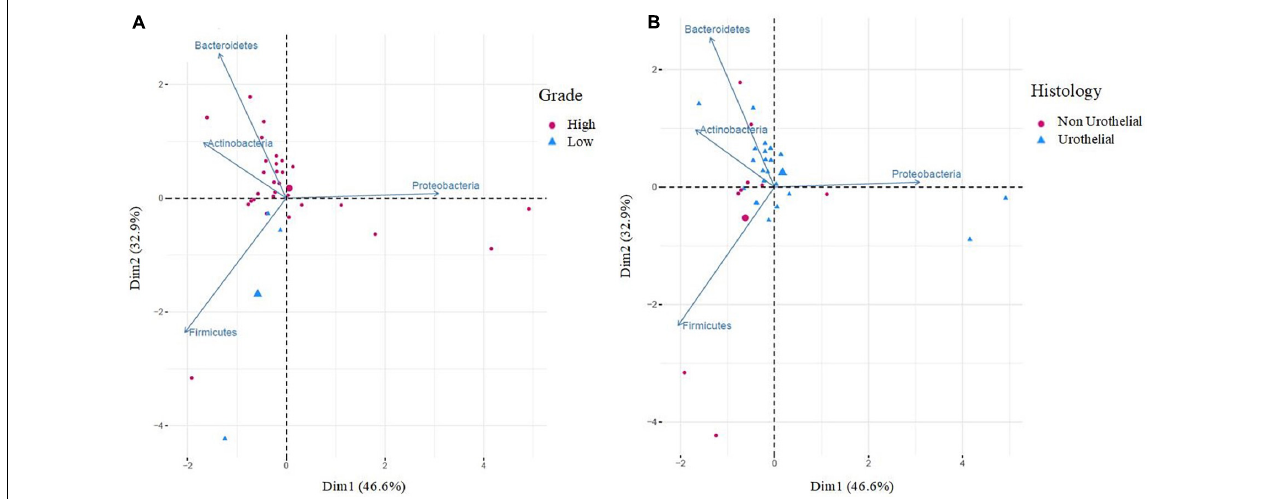
FIGURE 3 | Principal component analysis (PCA) of bacteria according to the grade of the tumor (A) and histology (B) , at the phylum level. PCA (A) shows the microbial community composition of tumor tissues in relation to high grade (red cicles, n = 29) and low grade (blue triangles, n = 3). PCA (B) shows the microbial community composition of tumor tissues in relation to histology: non-urothelial (red cicles, n = 9) and urothelial (blue triangles, n = 22). Principal component (PC1 and PC2) together, account for 79.5% of the variance in these data.